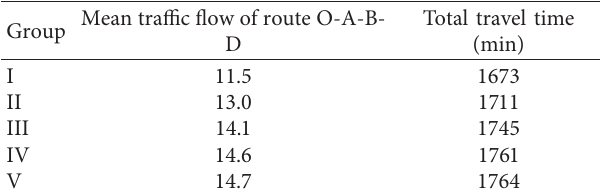
Figure 8: The relationship between the average travel time and the number of switches in five groups of experiments. (a) Group I, (b) Group II, (c) Group III, (d) Group IV, and (e) Group V. Table 11: Linear regression fitting parameters of the five groups of experiments.